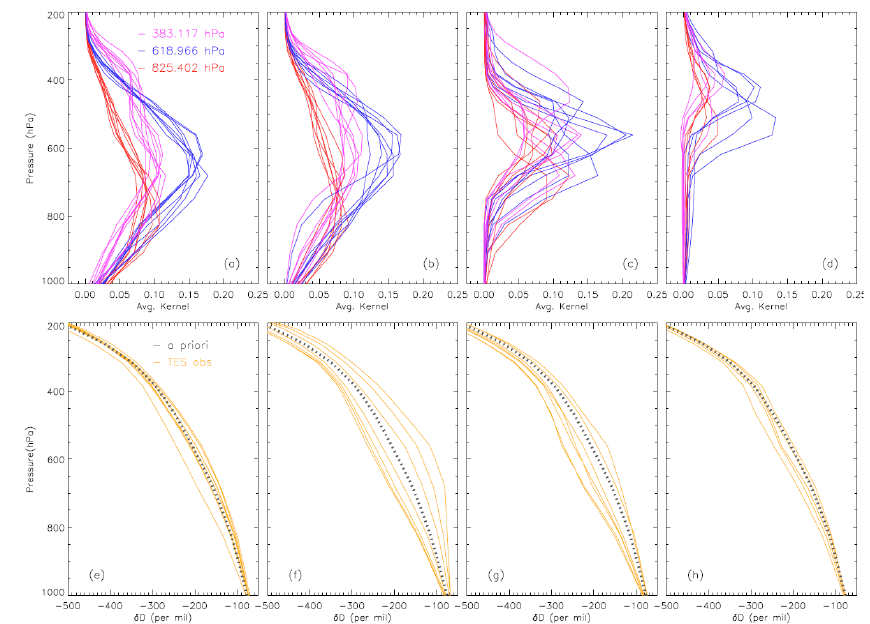
Fig. 1. TES averaging kernel rows corresponding to 825, 619 and 383 hPa and the a priori and the retrieved TES δD profile. Selected TES observations are over tropical ocean during 1 August 2007 (Run ID, 5889) except precipitating clouds (Three global measurements are selected due to lack of sampling number). (a) and (e) Clear sky, (b) and (f) nonprecipitating clouds, (c) and (g) boundary layer clouds and (d) and (h) precipitating clouds from 1 August 2007 to 8 August 2007 (Run ID, 5889, 5918 and 5948).